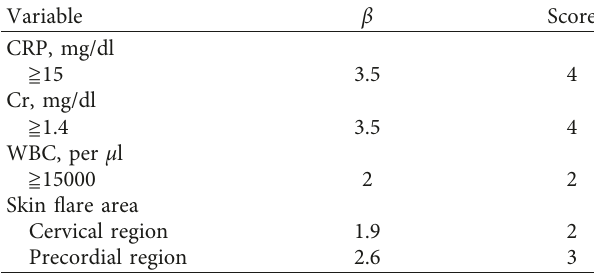
Table 4: Laboratory Risk Indicator for Necrotizing Fasciitis of the Oro-Cervical Region (LRINEC-OC) score.